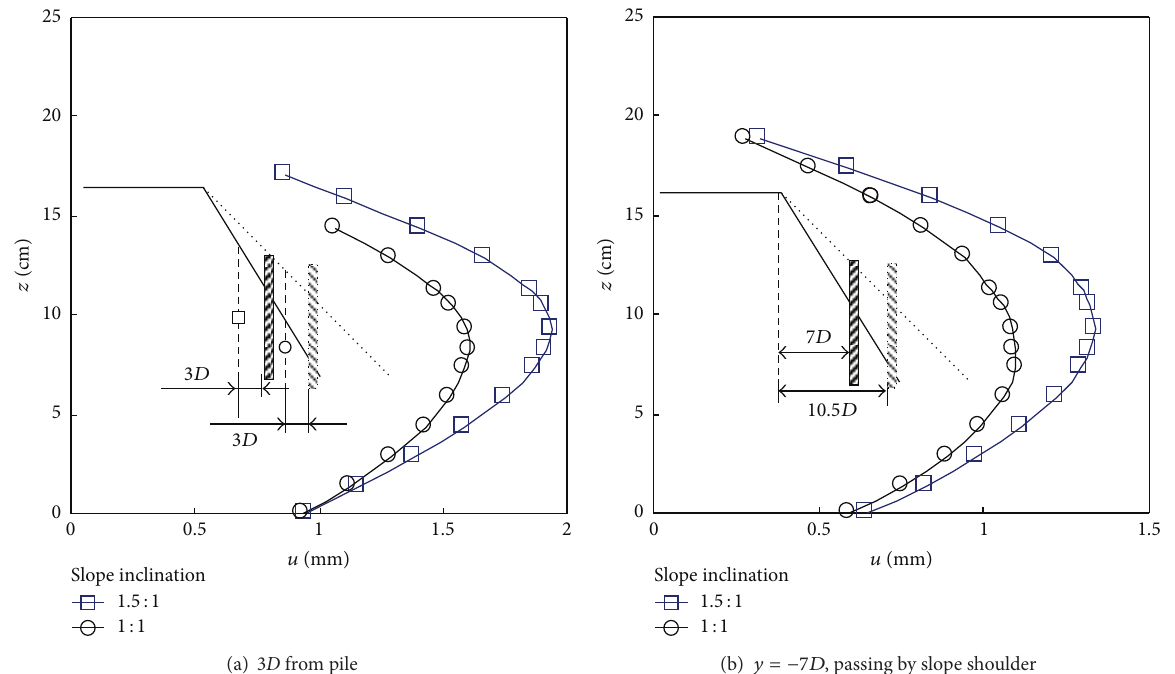
Figure 19: Influence of inclination of the slope by numerical analysis. D : pile diameter; u : horizontal displacement.